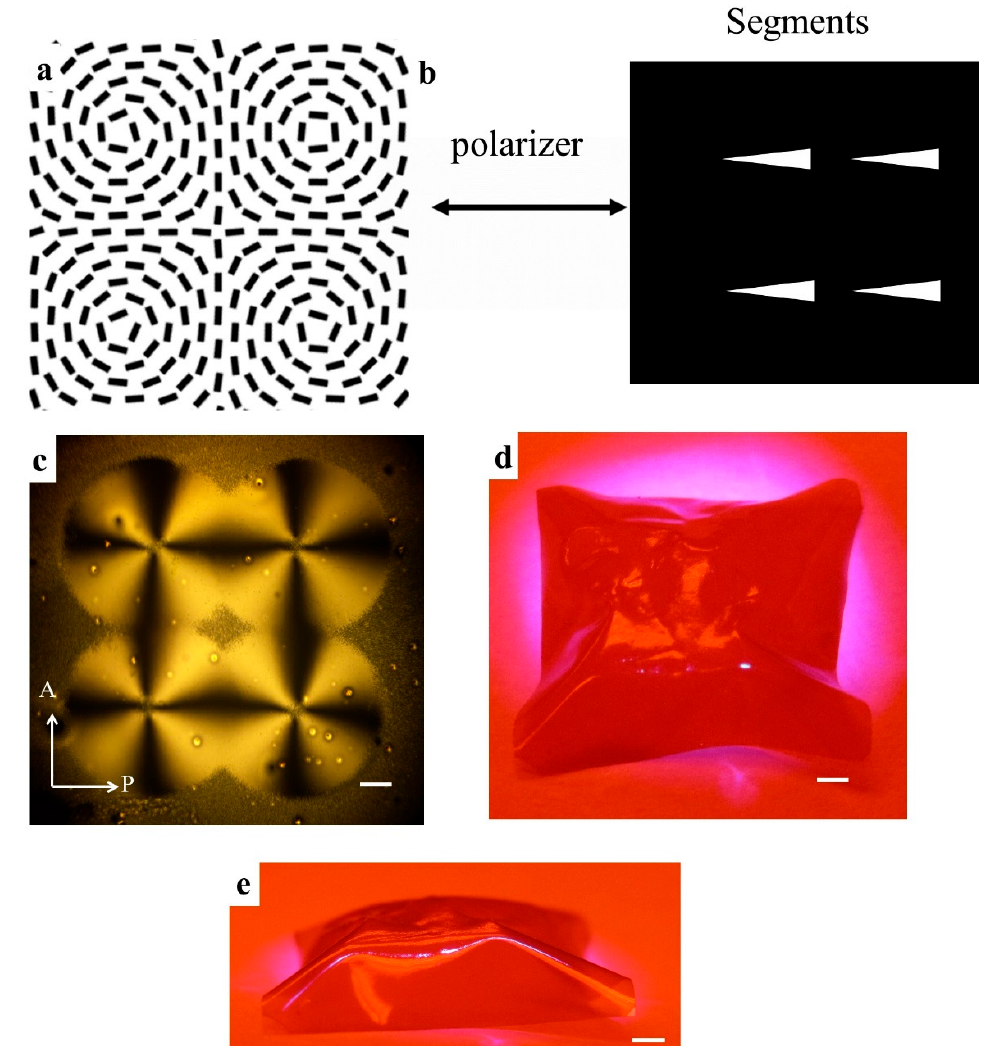
Figure 4 . Shape changes of the LCE film with a 2D lattice of circular +1 defects. ( a ) The director filed with a 2D array of circular +1 defects. ( b ) The starting positions of the polarizer and segments. ( c ) The POM image of the designed pattern. ( d , e ) The top ( d ) and side ( e ) views of the shaping deformation of the LCE film, respectively. The scale bars are 2.5 mm.